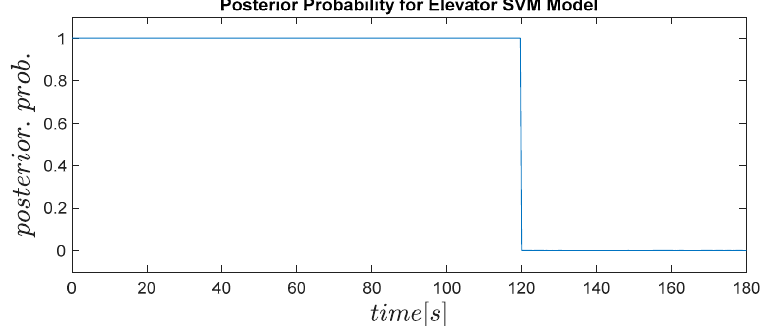
Figure 10. Posterior probability plotted against time for the elevator SVM model with 50% LOE